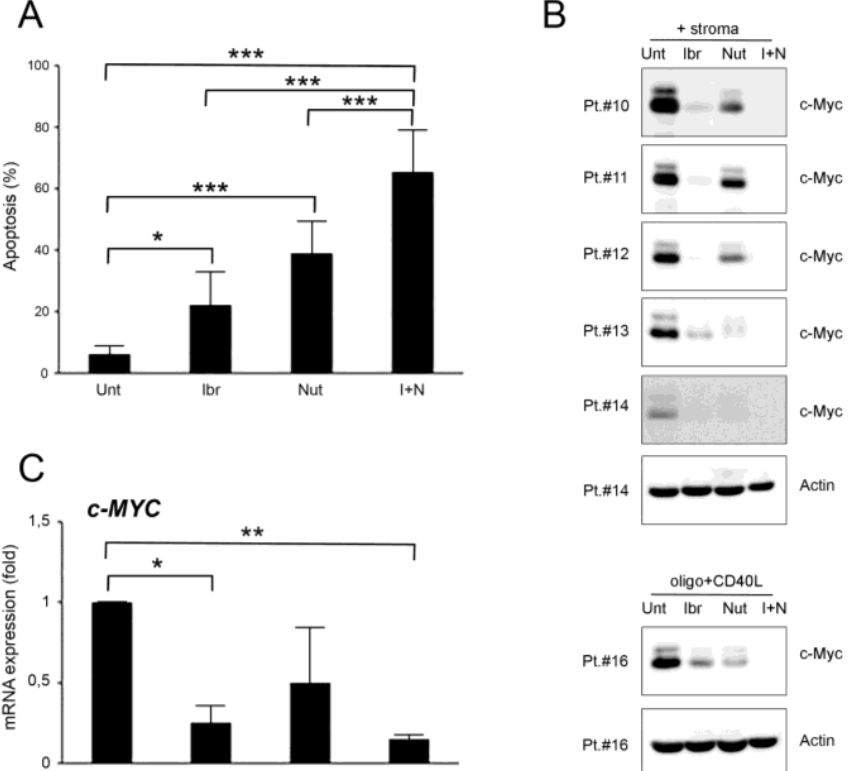
Figure 2. Ibrutinib and nutlin-3 combined treatment increases cytotoxicity in B-CLL activated cells. Patients’ derived B-CLL cells were grown in vitro with stroma or with CpG-ODN and CD40L and exposed to ibrutinib (10 µM), nutlin-3 (10 µM), ibrutinib+nutlin-3 (10 µM), or left untreated as a control, for 24–48 h. In ( A ), apoptosis level in response to treatments, calculated as percentage of Annexin V/PI double positive cells, was comparatively assessed after 48 h of treatment in cells stimulated with stroma. Results are reported as mean ± SD of seven independent experiments. In ( B ), Western blotting analyses of c-MYC protein levels 24 h post-treatment are shown for representative B-CLL patients. For illustrative purposes the untreated bands are re-used from Figure 1, and, for clarity, β -actin is shown as loading control for two patients. In ( C ), levels of c-MYC mRNA were analyzed by qRT-PCR at 24 h in cells stimulated with stroma and are expressed as fold of modulation with respect to untreated B-CLL cultures (set at 1). Results are reported as mean ± SD of three independent experiments. Asterisks indicate: *, p < 0.05; **, p < 0.01; ***, p < 0.001 (ANOVA followed by Bonferroni post-hoc test or Student’s t -test).